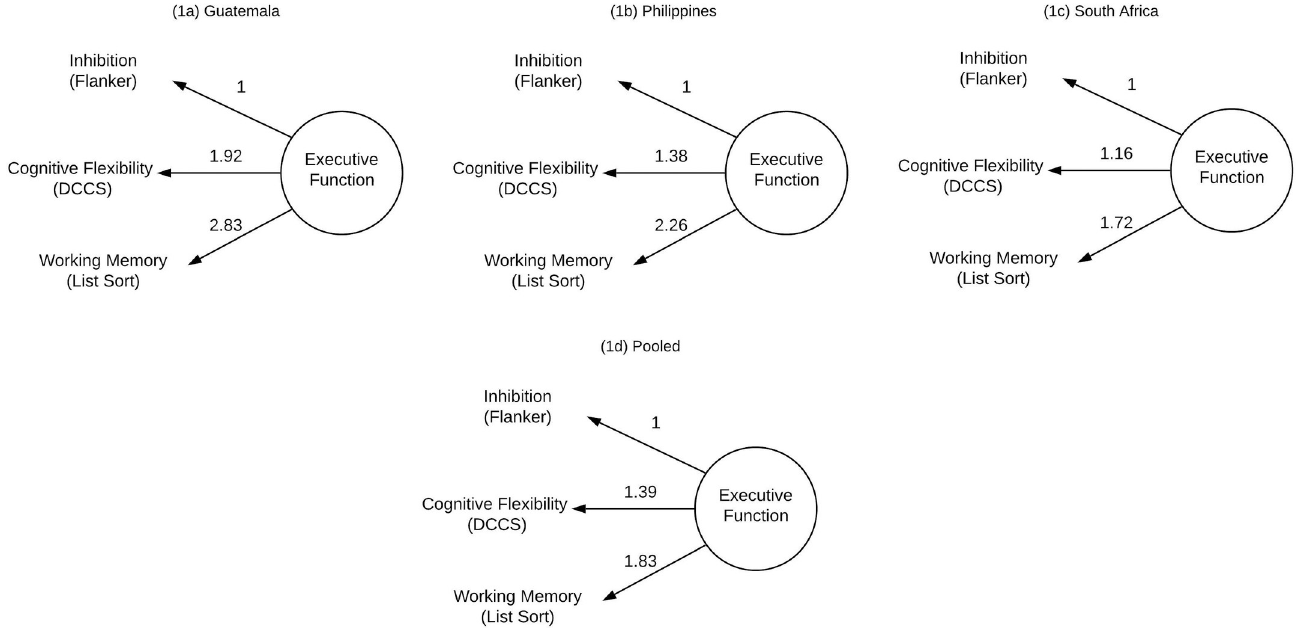
Fig 1. Unstandardized Factor loadings of each variable for (a) Guatemala (b) Philippines (c) South Africa and (d) pooled.